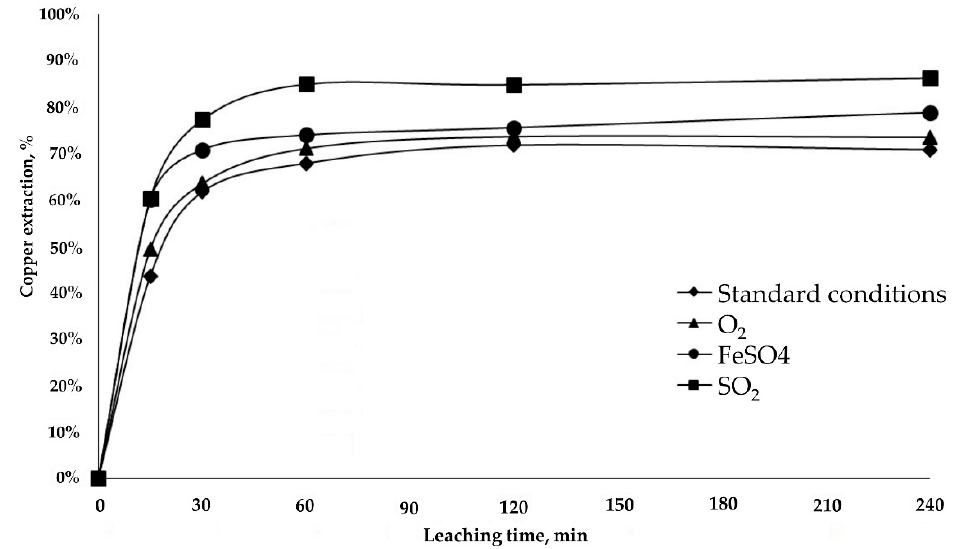
Figure 6. Copper extraction from the RA sample.